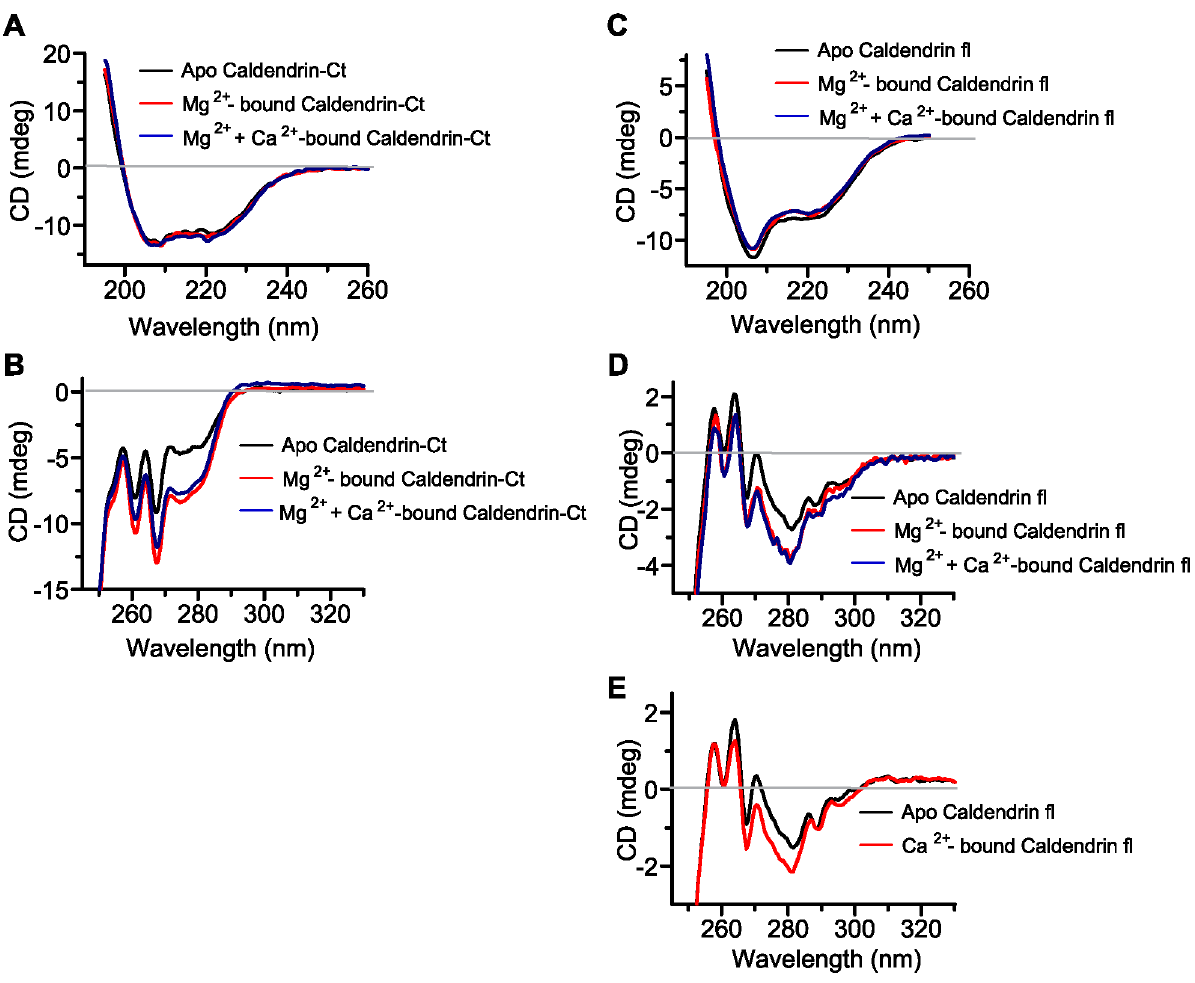
Figure 3. Far and Near UV- CD spectroscopy. (A) Far UV- CD spectra of the apo, Mg 2 + -bound and Mg 2 + + Ca 2 + bound common C-terminus of Caldendrin/CaBP1 shows no conformational change in secondary structure. (B) Near UV- CD spectra of the apo, Mg 2 + -bound and Mg 2 + + Ca 2 + bound common C-terminus of Caldendrin/CaBP1 exhibit significant change in tertiary structure. (C) Far UV- CD spectra of the apo-, Mg 2 + -bound and Mg 2 + + Ca 2 + -bound full length Caldendrin. Mg 2 + binding to apo-Caldendrin causes a mild change in the secondary structure of the protein. Ca 2 + binding to Mg 2 + - bound Caldendrin has no detectable effect on the secondary structure of the protein. (D) Near UV- CD spectra of apo-, Mg 2 + -bound and Ca 2 + - bound Mg 2 + + Ca 2 + -bound full length Caldendrin. Mg 2 + binding to apo-CDD causes a significant change in the tertiary structure of the protein, whereas Ca 2 + binding to Mg 2 + - bound Caldendrin has no effect. (E) Ca 2 + -titration of the apo-protein had a clear effect on the structure. Representative spectra for each condition are